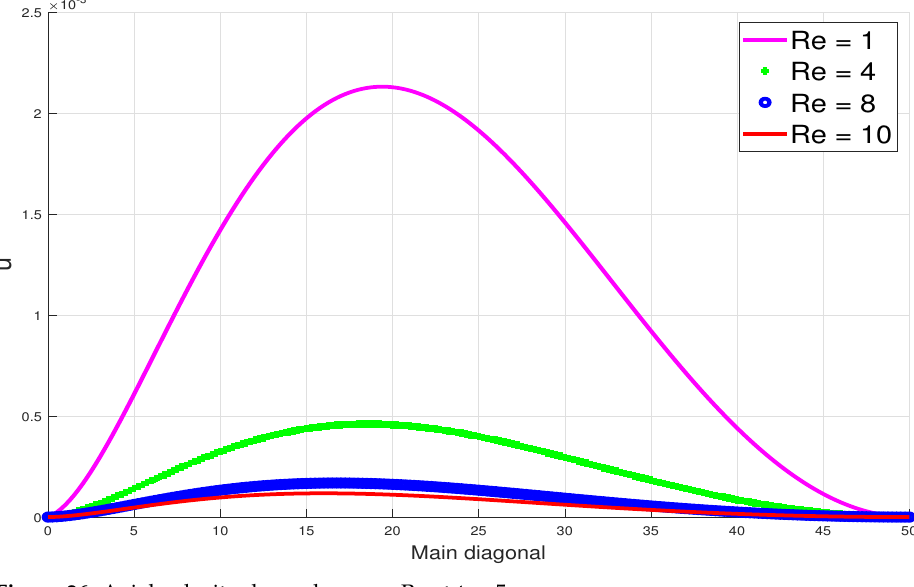
Figure 26. Axial velocity dependence on Re at t = 5.